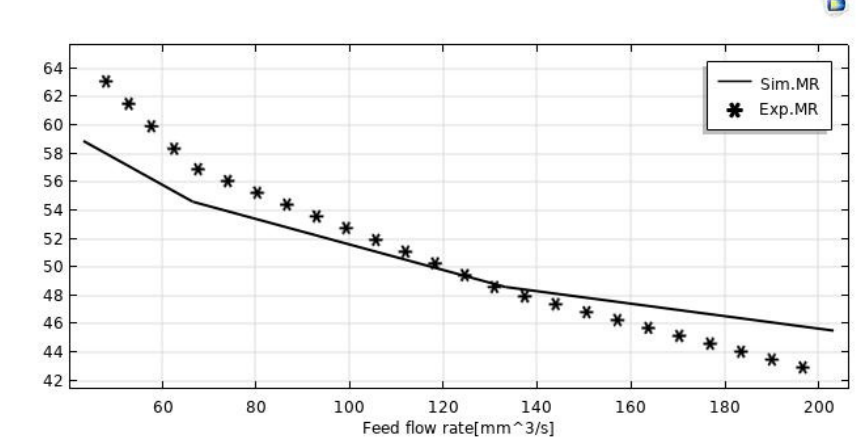
Figure 3. HI conversion in the MR vs. feed flow rate at T = 400 °C, p = 1 bar, and sweep gas flow rate = 333.33 mm 3 /s. rate = 333.33 mm 3